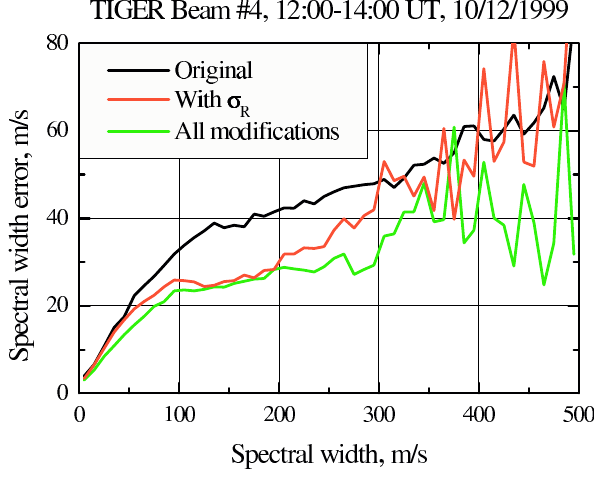
Fig. 8. The same as in Fig. 7 but for a spectral width fitting error.